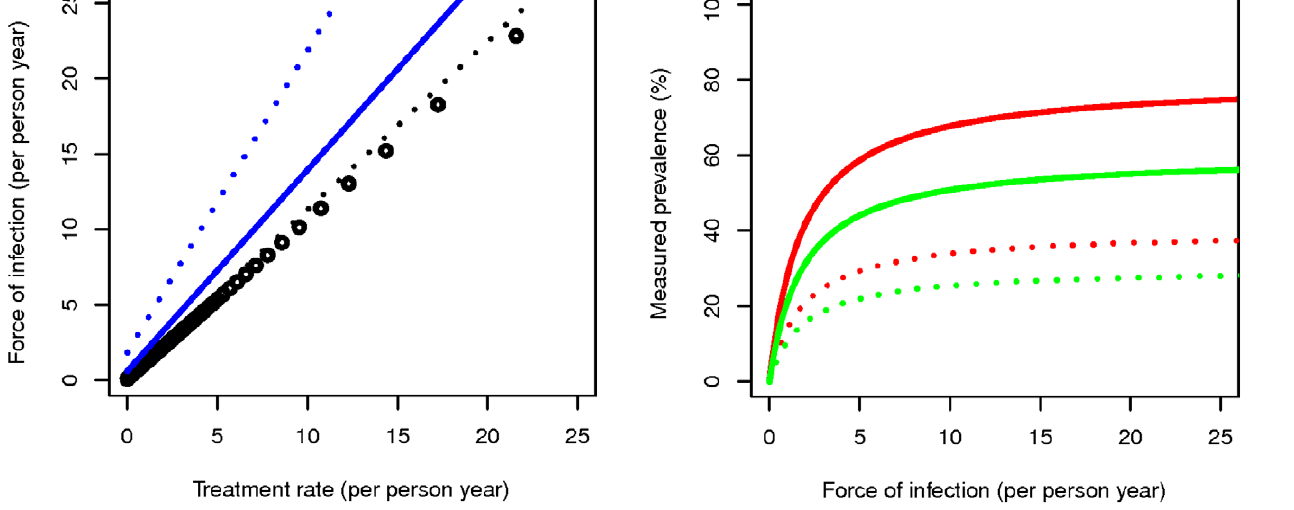
Figure 2. Measured prevalence against force of infection. Measured prevalence against force of infection ( l 0 : new infections prior to any treatment per person year) at 20% (red lines) and 40% (green lines) treatment rate of new infections; perfect detectability (solid lines) and 50% detectability (dotted lines), with an average natural parasitaemia duration of 200 days.